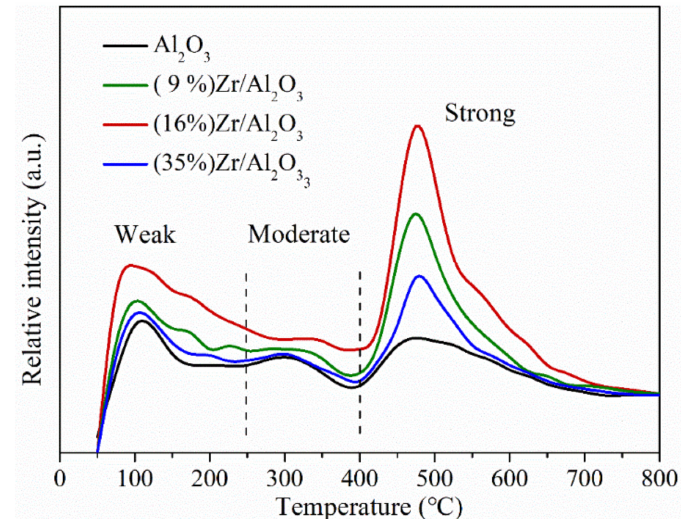
Figure 3. NH 3 -TPD profiles of